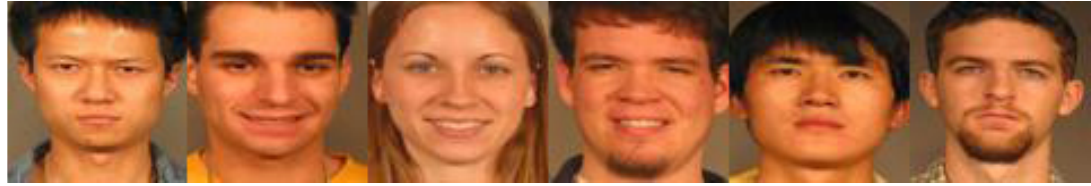
Figure 18. Sample images from the FRGC face image